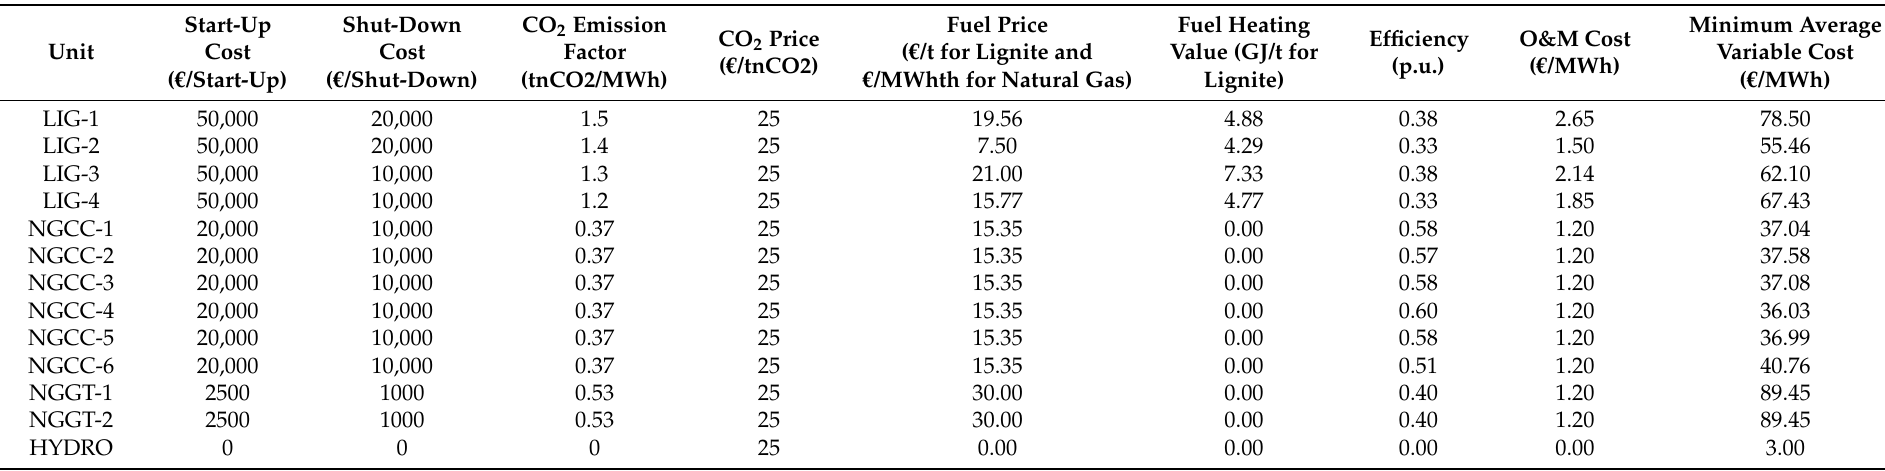
Table 1. Main economic data of the studied power system.